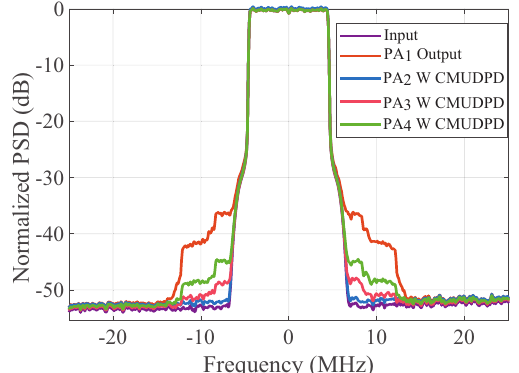
Figure 15. Experimental results of PSD with (W)